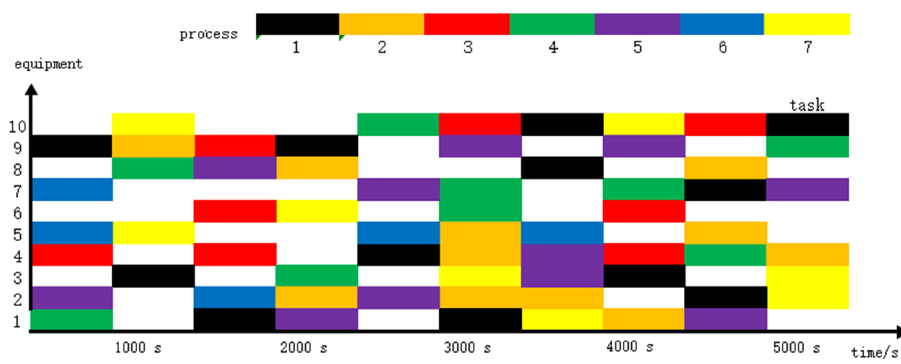
Figure 9. Scheduling scheme for multi-constrained intelligent scheduling. The experimental results showed that the production time and equipment utilization rate required to complete 500 pieces of clothing were 23,027 s and 61% in the production plan before scheduling, 20,156 s and 64% in the scheduling under the assumption of